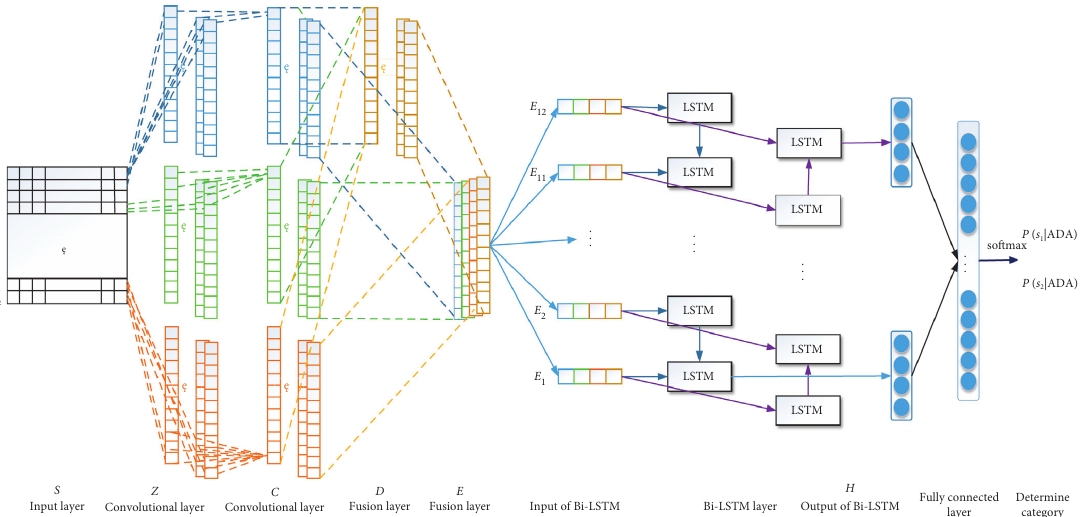
Figure 4: Convolution operation, Bi-LSTM, and semantic classification process.